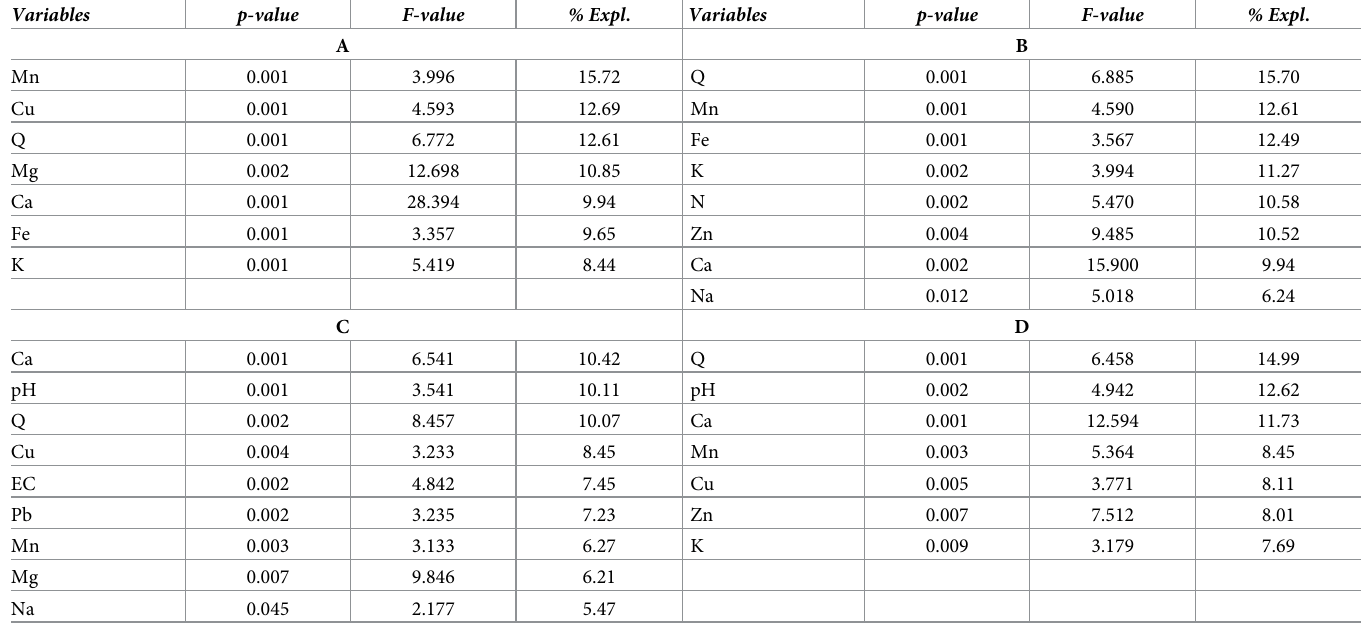
Table 8. Adjustment coefficients for the models presented in (Fig